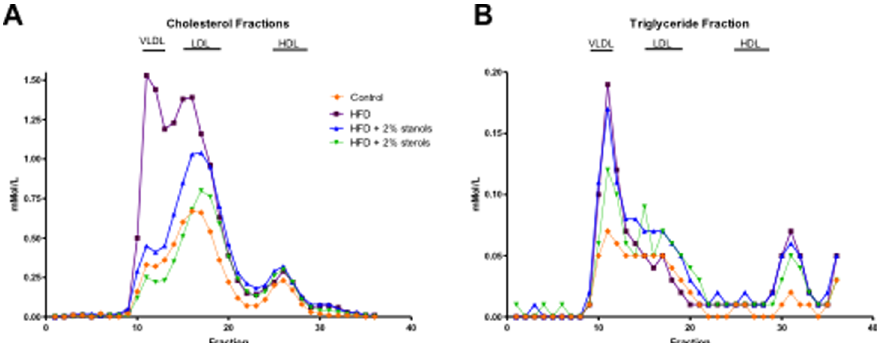
Figure 5. Serum lipid and lipoprotein profiles. (A, B) Using FPLC, serum lipid and lipoprotein profiles were analyzed in all experimental groups. On the chromatogram, the X-axis represents the fractions present in the mixture as a peak, thereby identifying the different components of the mixture. On the Y-axis, the amount of the different fractions can then be read (nMol/l).